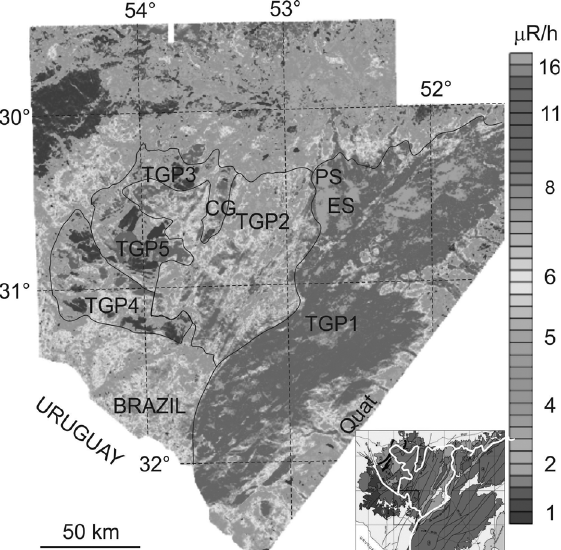
Figure 4 - Identi fi cation of major total gamma spectrometry provinces in the Sul-Riograndense Shield (e.g., TGP1). TGP5 = granitic plutons in the foreland. Quat = Quaternary coastal plain, ES = Encruzilhada block, PS = Piquiri syenite. For interpretation of the references to color in this fi gure legend, the reader is referred to the web version of this article.